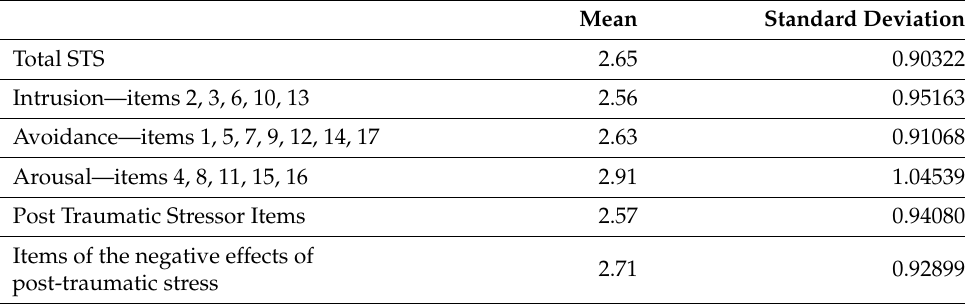
Table 2. Mean and standard